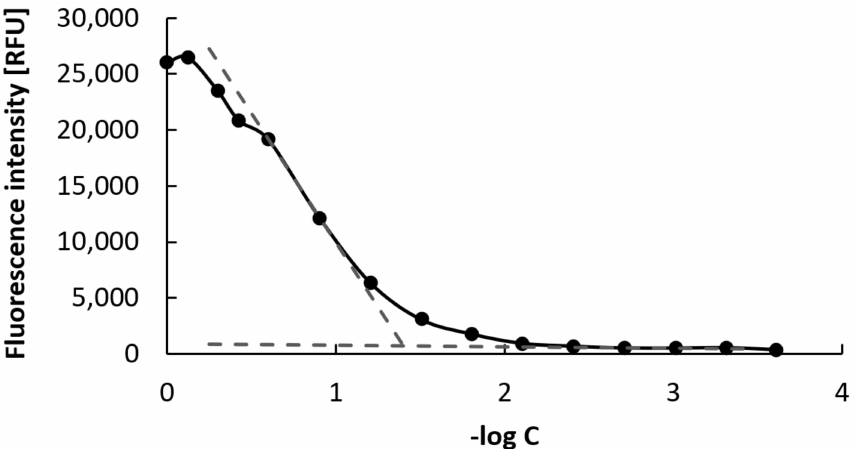
Figure 1. Critical micellar concentration (CMC) of micellar polymer (MP). The dependence of fluorescent intensity on the negative logarithm of the sample concentration for determination of CMC by fluorescence. Nile Red dye in phosphate-buffered saline (PBS; 10 mM, pH 7.4) was used at the concentration of 1 µ M ( λ ex = 550 nm, λ em = 630